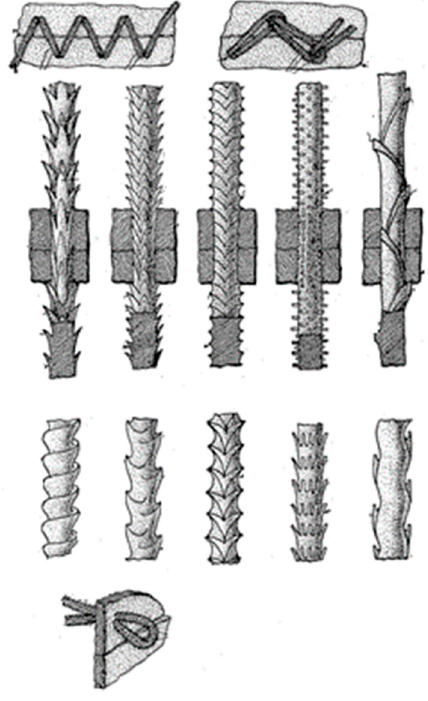
Figure 2. John Alcamo’s surgical suture con fi gurations with unidirectional projections, teeth and/or depressions [16].